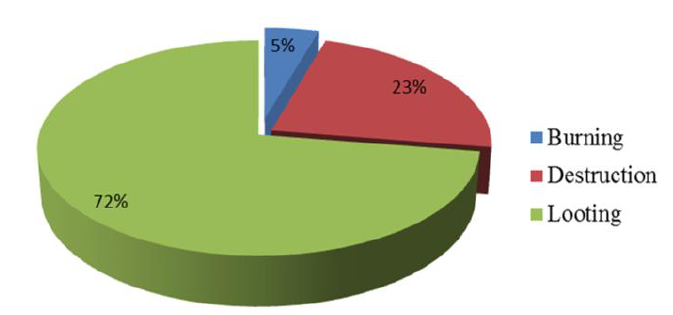
Figure 3: Percentage evaluation of the damage to